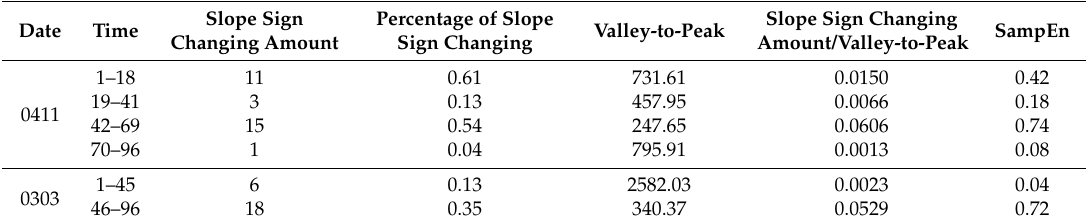
Table 1. Data for the net load of a province on 3 March and 4